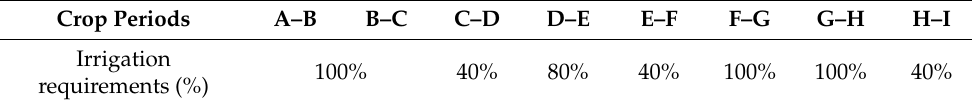
Table 3. Percentage of irrigation requirements adopted in the deficit irrigation management (DIM).